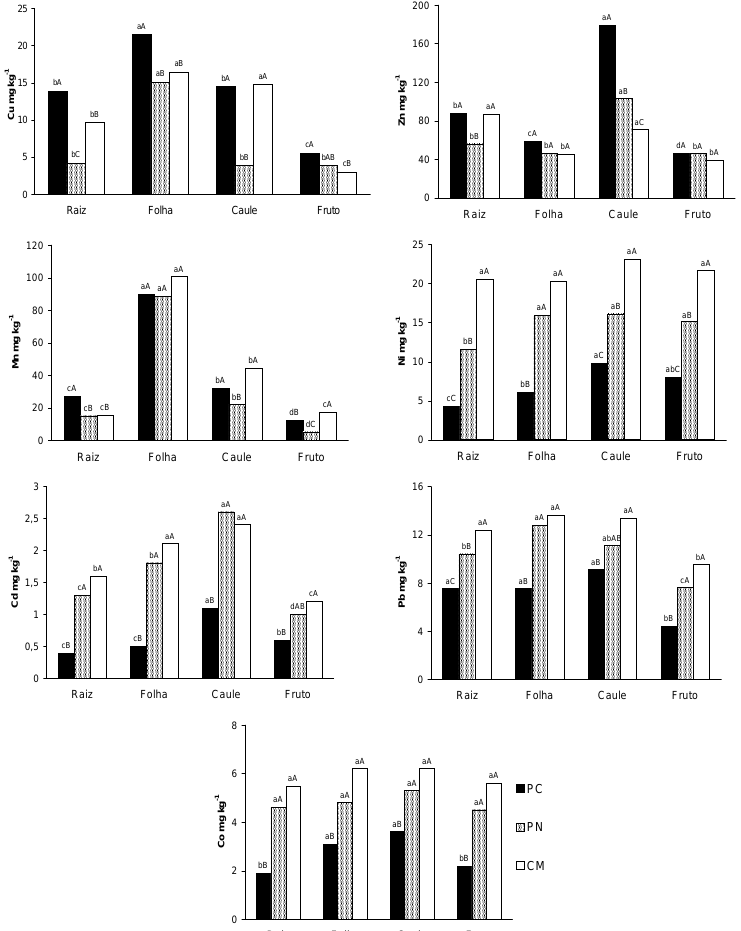
Figura 2. Concentração de metais pesados nas plantas de feijão-de-vagem nos três sistemas de preparo do